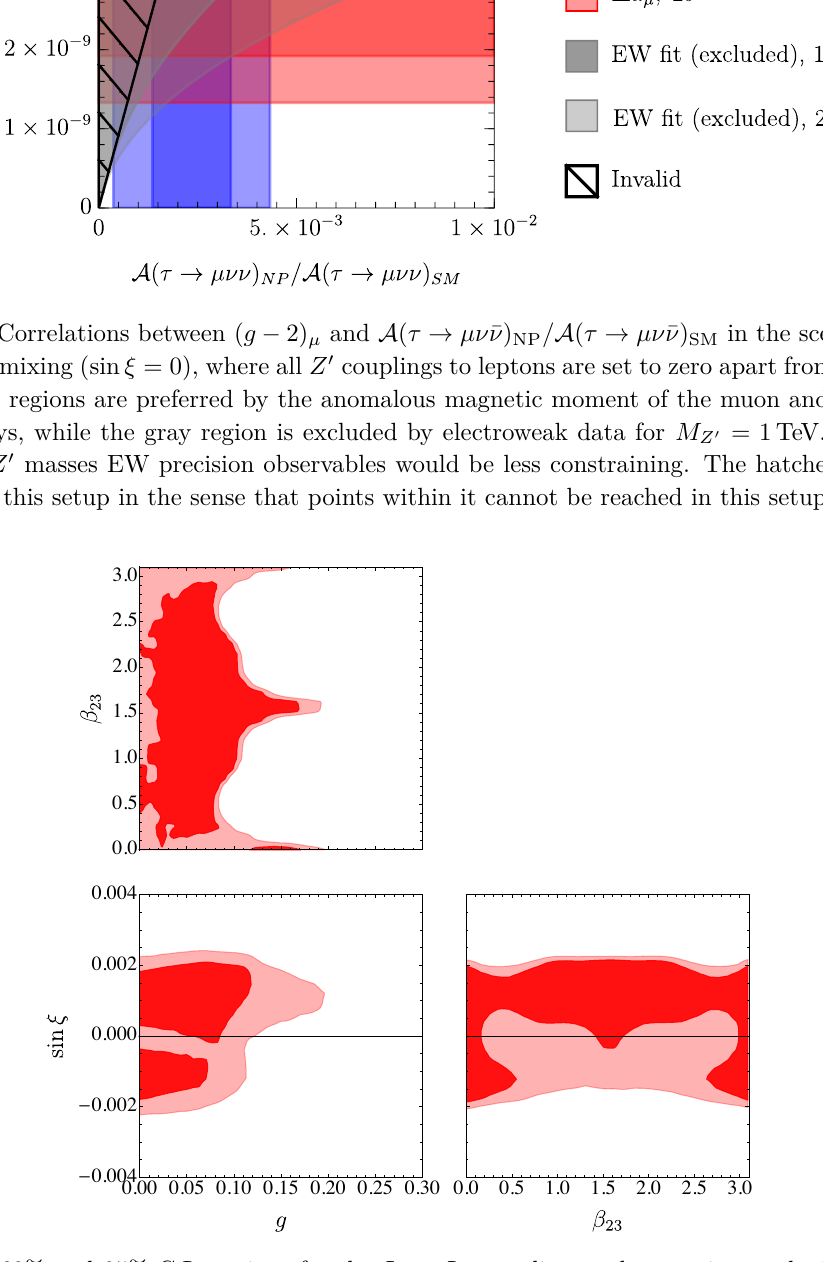
Figure 9. 68% and 95% C.L. regions for the L µ − L τ coupling g , the rotation angle β 23 and the mixing angle sin ξ